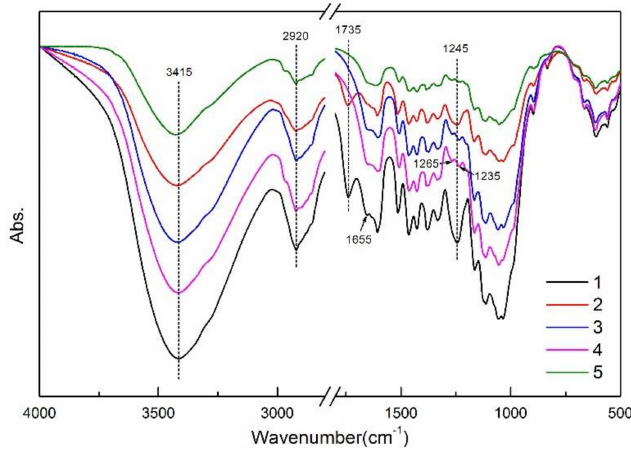
Figure 1. FTIR spectra of treated and untreated BF. (1) UB; (2) DB; (3) ADB4; (4) ADB6; (5)